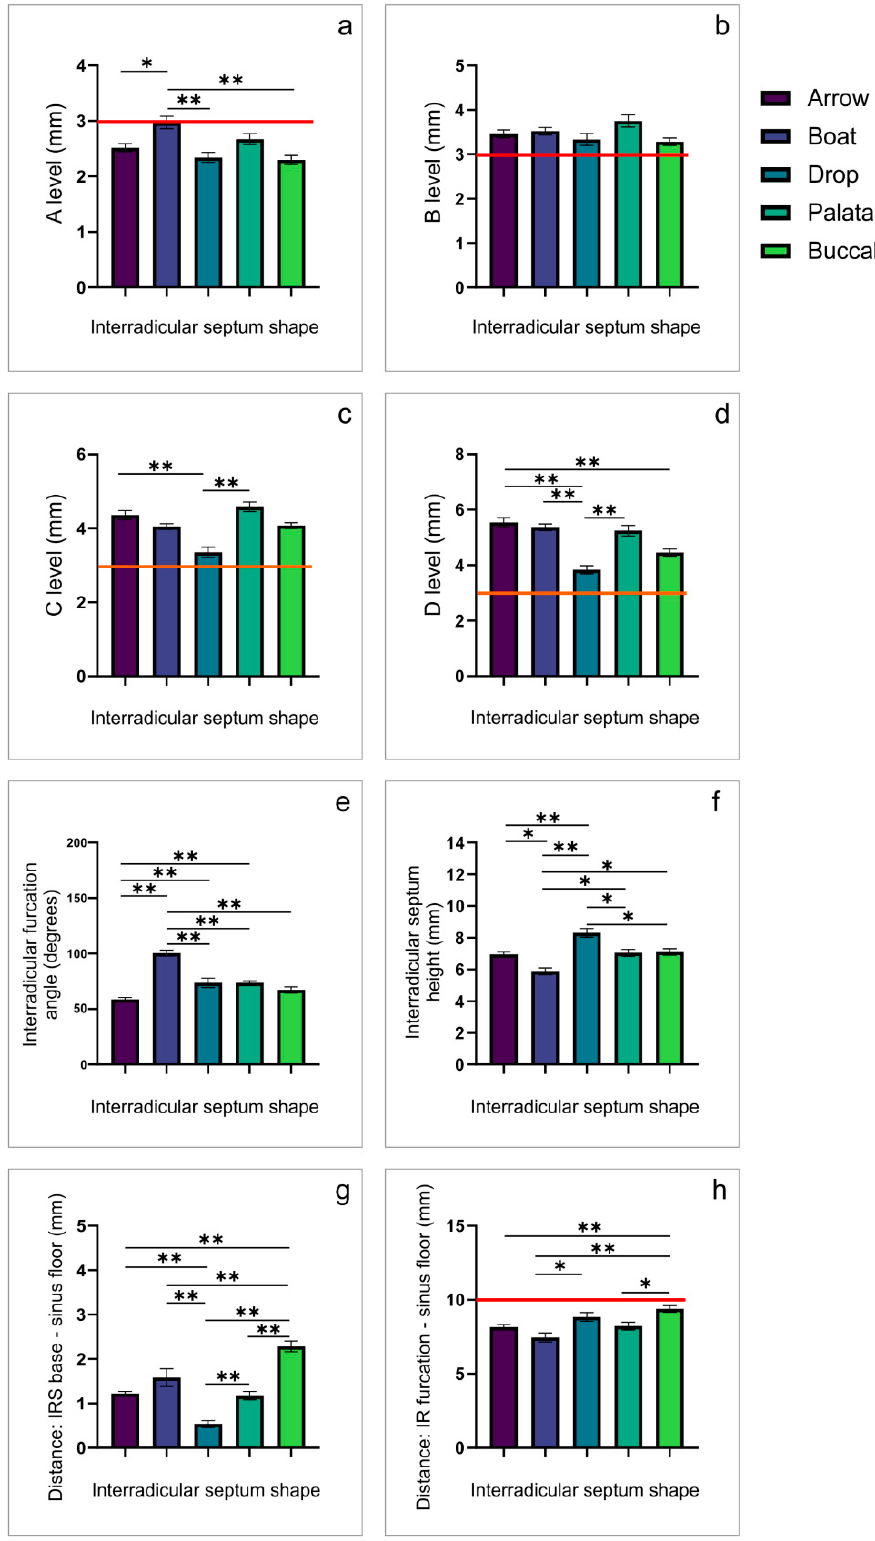
Figure 4. The observed differences in IRS morphometric parameters according to the IRS shape for the second maxillary molars obtained in the coronal CBCT view (the margin of clinical